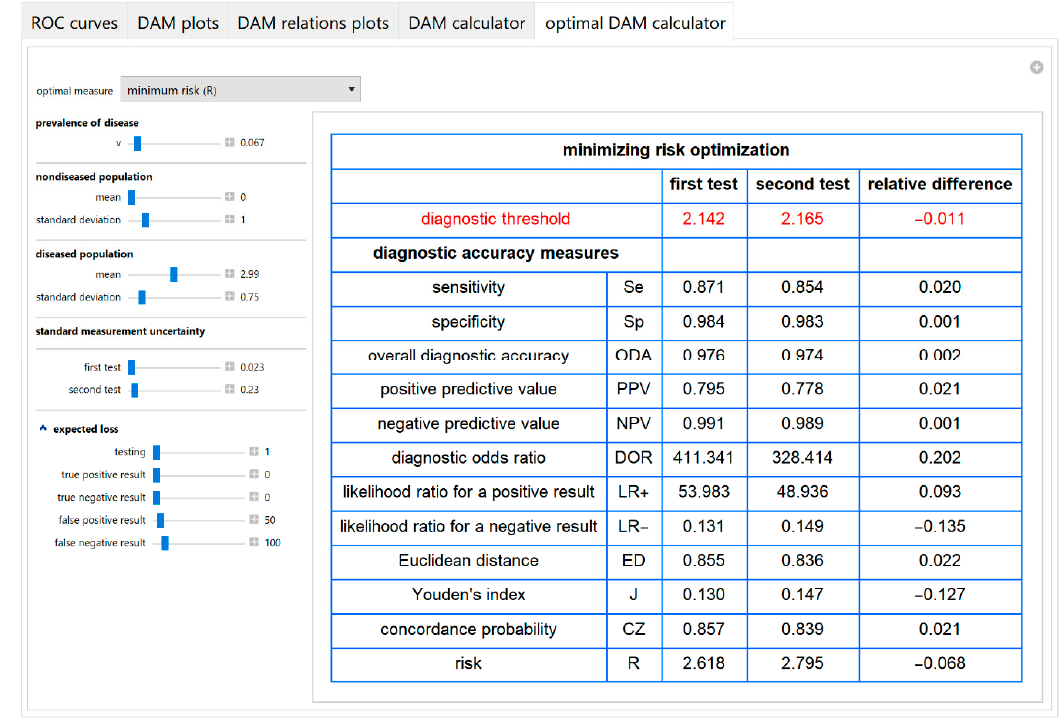
Figure 11. Optimal DAM calculator module screenshot. Calculated diagnostic accuracy measures of two screening or diagnostic tests measuring the same measurand with different uncertainties, minimizing risk ( R ) and their relative differences, with the settings at the left.